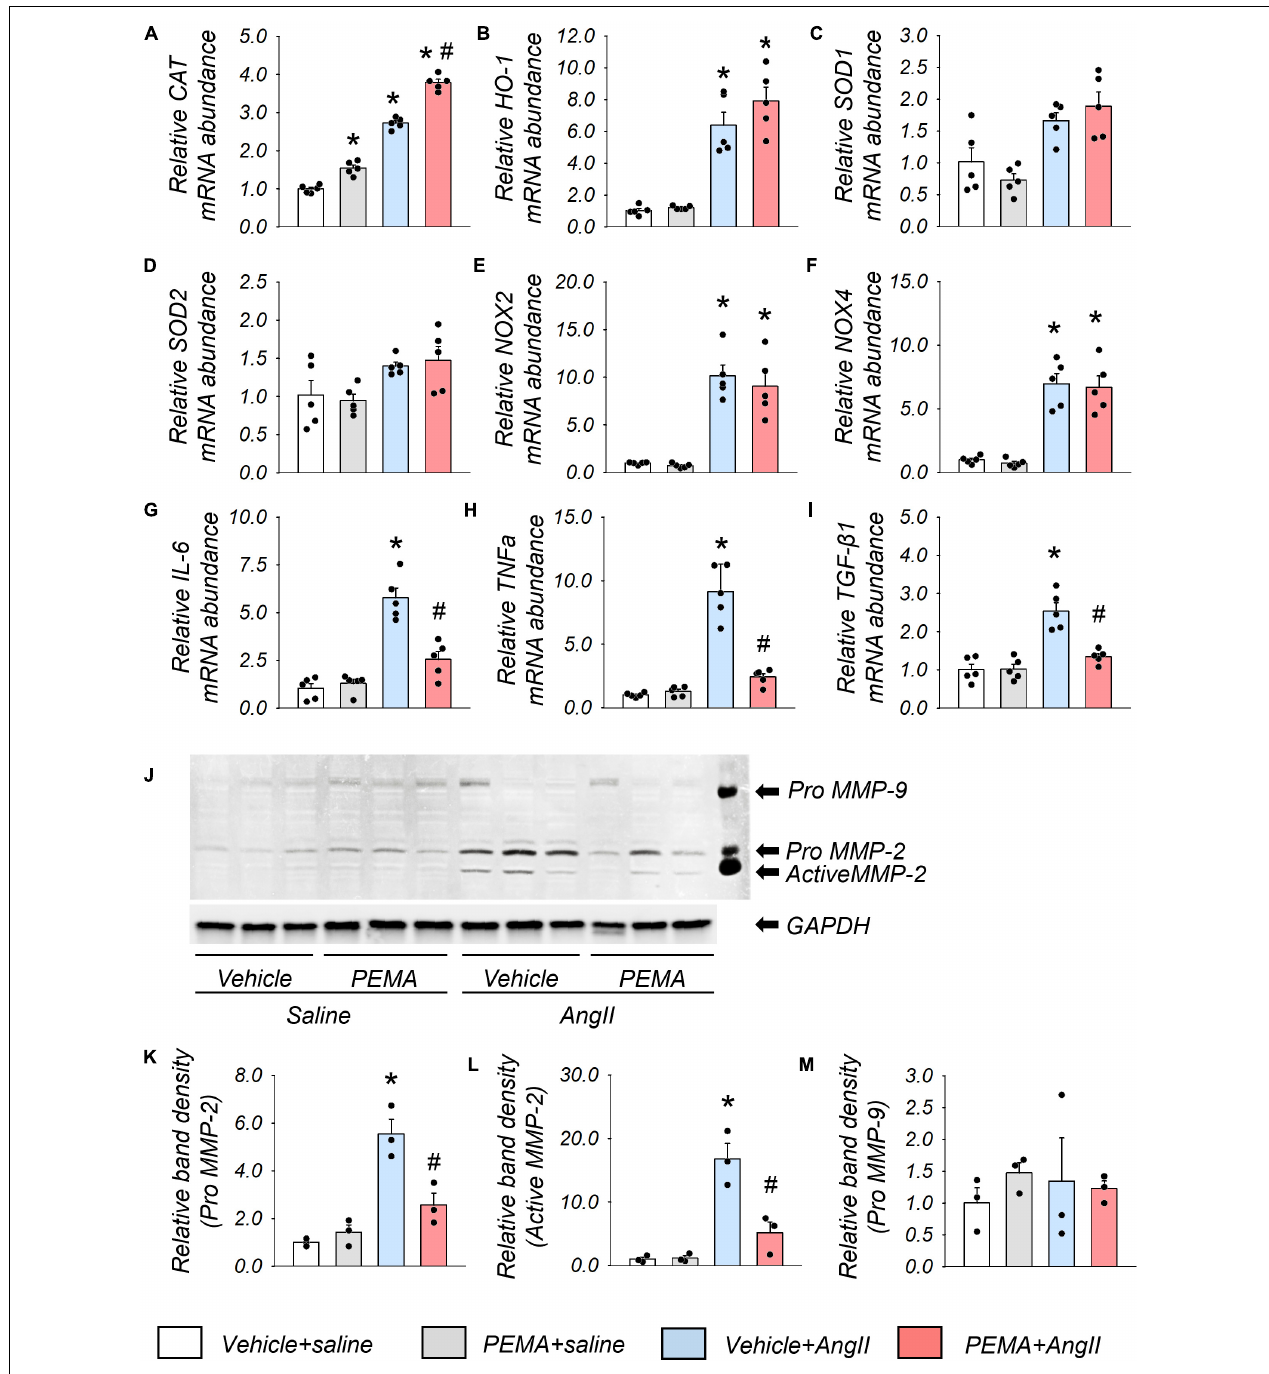
FIGURE 5 | Gene expression and matrix metalloproteinase (MMP) activity in the aortic tissues extracted from the acute model of ApoE − / − mice. (A–I) mRNA expression levels of catalase ( CAT ), heme oxygenase-1 ( HO-1) , superoxide dismutase 1 ( SOD-1 ), SOD-2 , nicotinamide adenine dinucleotide phosphate oxidases ( NOX2 and NOX4 ), Interleukin-6 ( IL-6 ), tumor necrosis factor- α ( TNF α ), and transforming growth factor- β 1 ( TGF- β 1 ) in the suprarenal aortic tissues extracted from vehicle-treated saline-infused (vehicle + saline), pemafibrate-treated saline-infused (PEMA + saline), vehicle-treated angiotensin II-infused (vehicle + AngII), and PEMA-treated angiotensin II-infused (PEMA + AngII) mice (n = 5 per group, performed in duplicates). All gene expression analyses were conducted using quantitative reverse transcription-polymerase chain reaction, and each gene expression level was normalized using glyceraldehyde 3-phosphate dehydrogenase ( GAPDH ). (J) MMP-2, and MMP-9 activities in the abdominal aorta of mice infused with saline or AngII for 4 weeks were analyzed using gelatin zymography. Quantitative analysis of pro-MMP-2 (K) , active MMP-2 (L) , and pro-MMP-9 (M) in the abdominal aorta ( n = 3 per group, performed in duplicates). For gelatin zymography, the samples matched to the median body weight of each group were selected. Data are expressed as mean ± standard error of the mean. All analyses were performed using analysis of variance and Bonferroni corrections. * p < 0.05 vs. the vehicle-treated saline-infused group; # p < 0.05 vs. the vehicle-treated AngII-infused group.